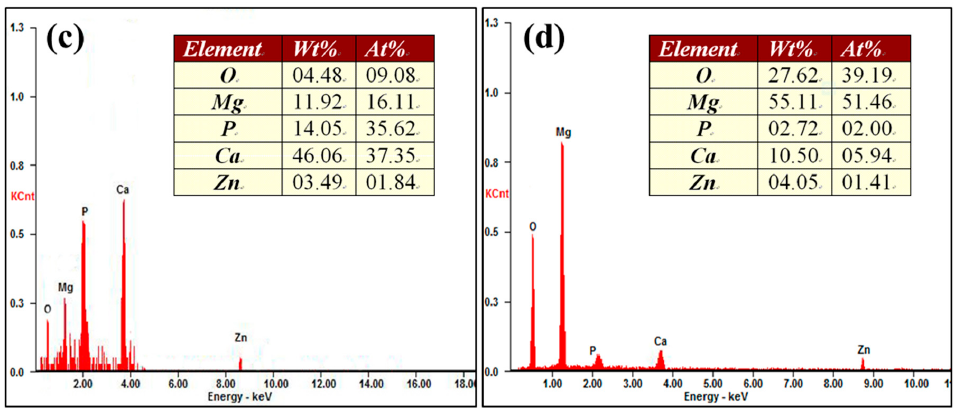
Figure 5. The enlarged view of areas in Figure 4c and EDS result of the precipitates marked by the arrow: enlarged view of area 1 ( a ) and area 2 ( b ); EDS result of the arrow A ( c ) and arrow B ( d ).